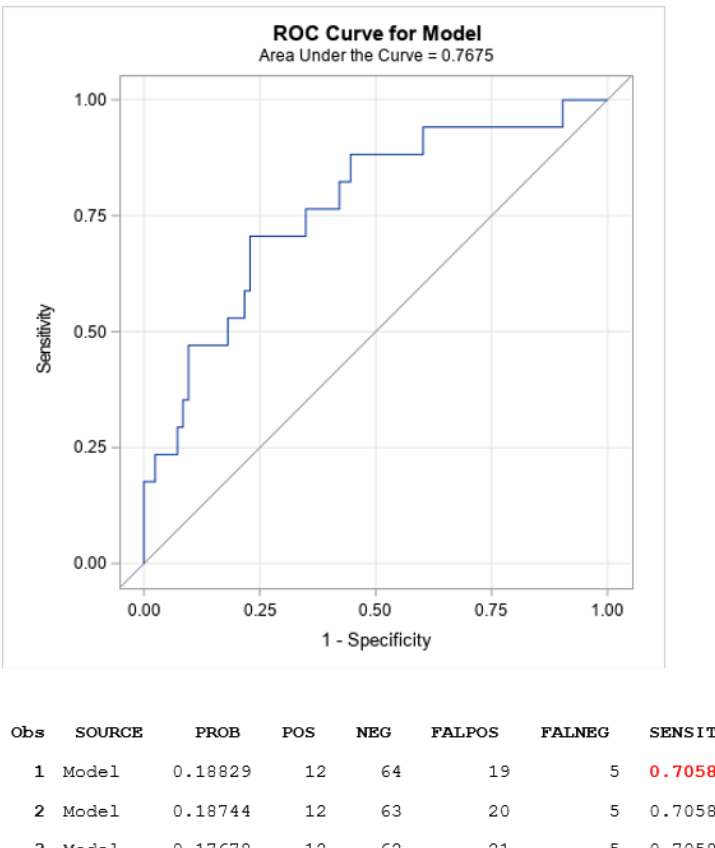
Figure 3. Receiver-operating characteristic curve of amoxicillin plasma concentration in relation to its attributable neurotoxicity or not. AUC: area under the curve; 95% CI, 95%: confidence interval.